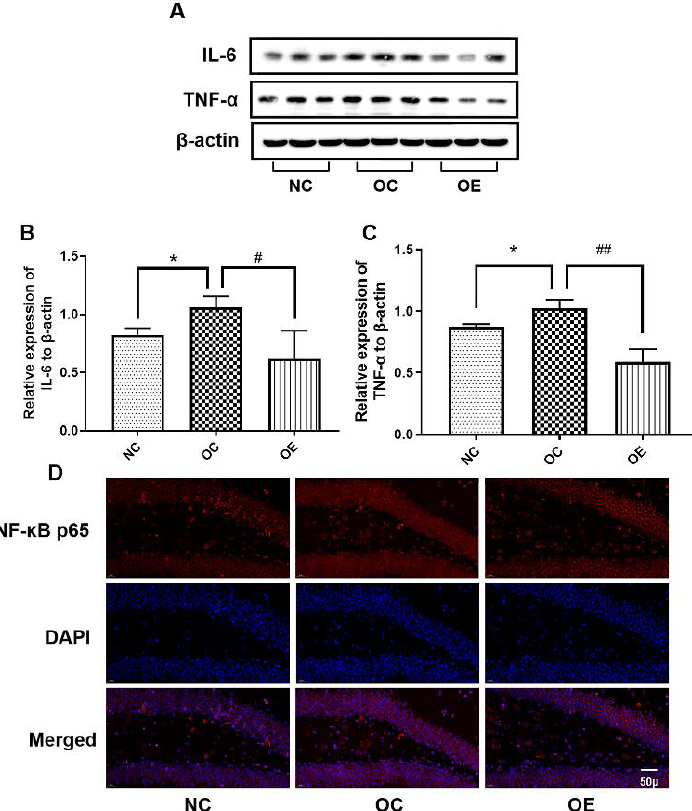
Figure 4. The Western blot of proteins associated with neuroinflammation ( A ) and corresponding statistical analysis of IL-6 ( B ) and TNF- α ( C ) expression levels, as well as the immunofluorescence of NF- κ B p65 ( D ) in hippocampal tissues. All data were presented as mean ± standard deviation (M ± SD) ( n = 3 mice per group). Immunofluorescence images were acquired under a 400× optical microscope. Compared with the NC group, * p < 0.05; compared with the OE group, # p < 0.05, ## p < 0.01.